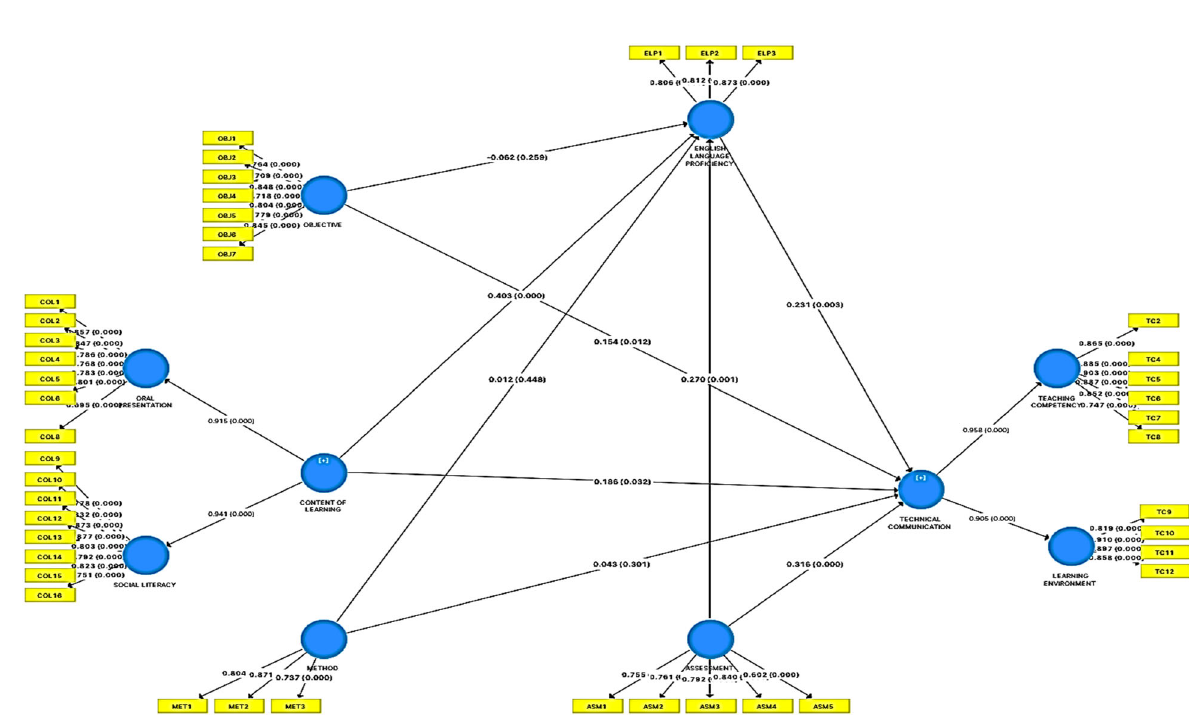
Fig. 3 The structural model. The summary of the structural model analysis with the loading values between the indicators and each construct and the coef fi cient values between constructs.